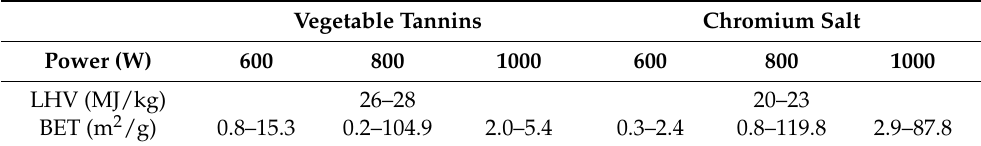
Table 3. LHV and BET surface area of